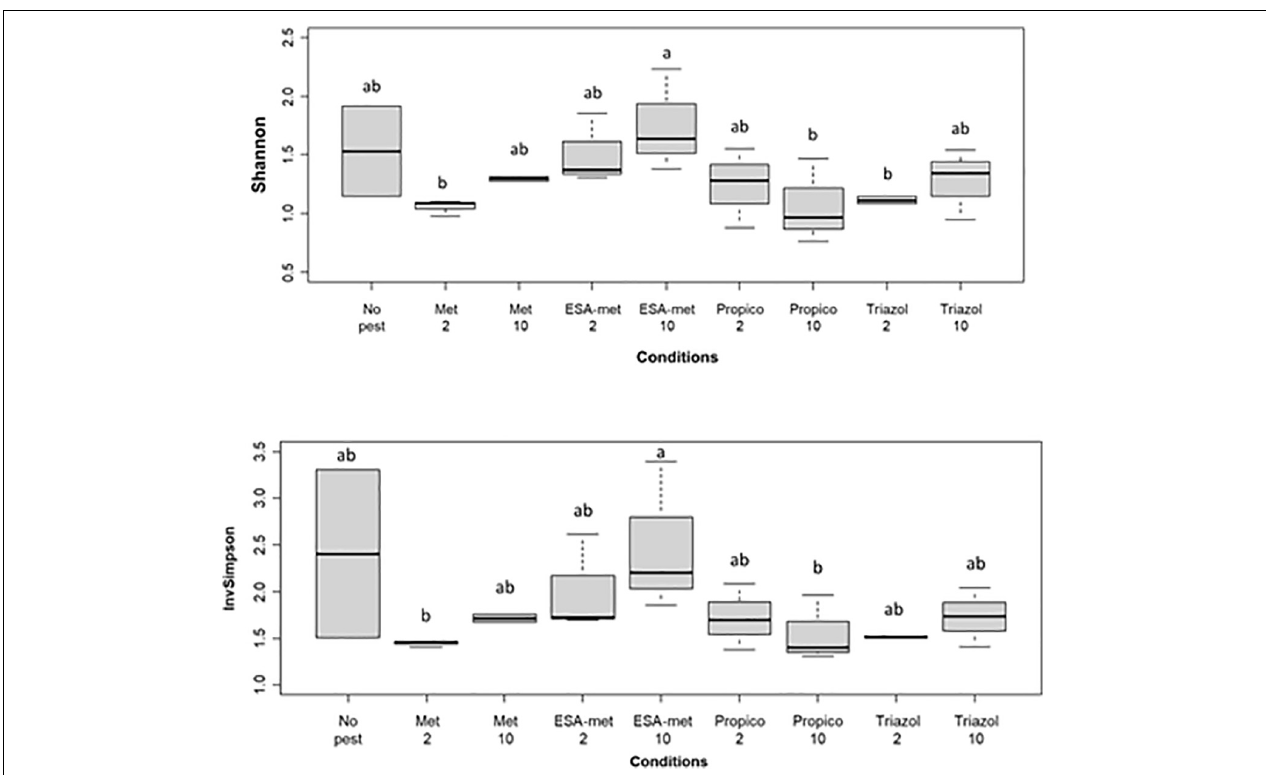
FIGURE 8 | Biodiversity index of the bacterial communities at the end of batch experiments (20 days): (Top) Shannon index and (Bottom) InvSimpson index. No pest: control (absence of pesticides or metabolites); Met: metolachlor; ESA-met: ESA-metolachlor; Propico: propiconazole; Triazol: 1,2,4-triazole. 2 and 10 are pesticide or metabolite concentrations in µ g/L. Significant differences between conditions were searched applying the Kruskal-Wall is non-parametric test and are mentioned as a, b, and c